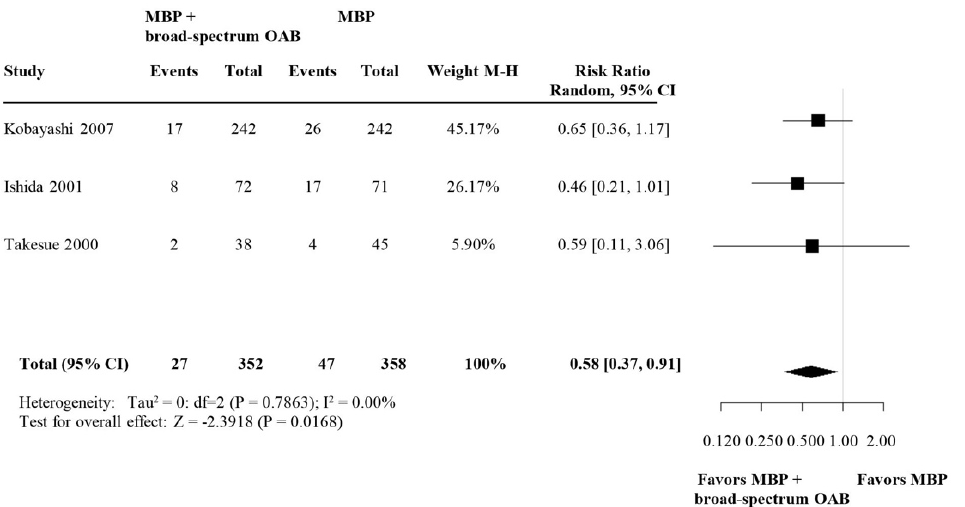
Figure 7. Forest plot comparing SSI rate for patients receiving broad-spectrum OABs (defined as OAB that are effective against both aerobe and anaerobe bacteria) in addition to MBP and i.v. antibiotic prophylaxis versus MBP alone with i.v. antibiotic prophylaxis. A random effects model was used to perform the meta-analysis and risk ratios are quoted including 95% confidence intervals.